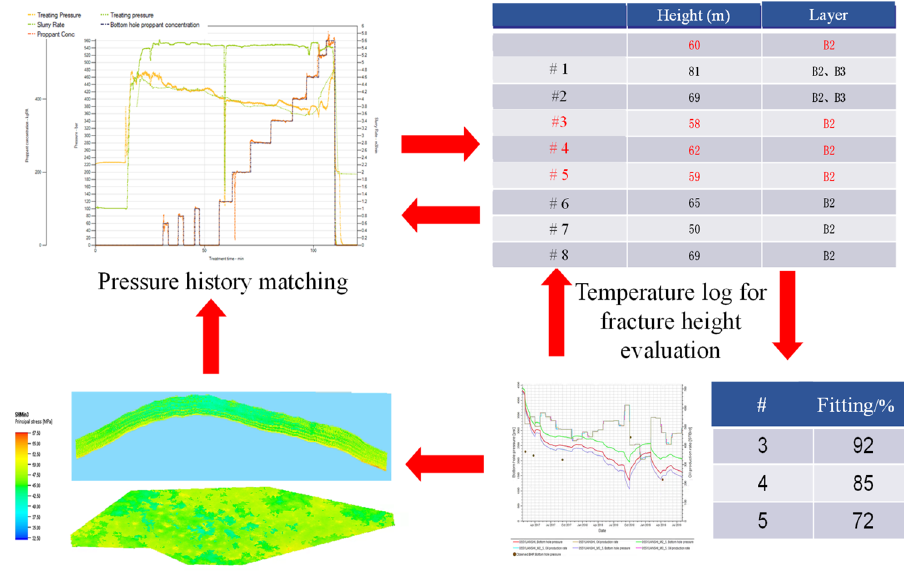
Fig. 15 Comprehensive flow chart of the model